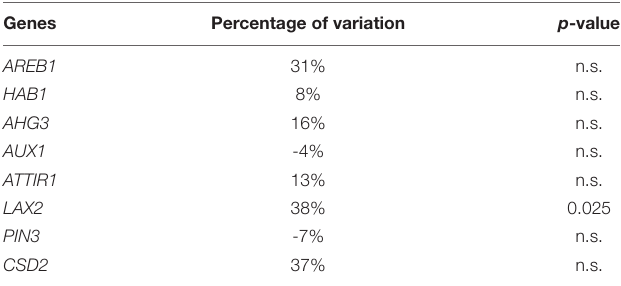
TABLE 4 | Percentage variation in the gene expression level of treated samples with respect to the untreated ones. Genes Percentage of variation p -value AREB1